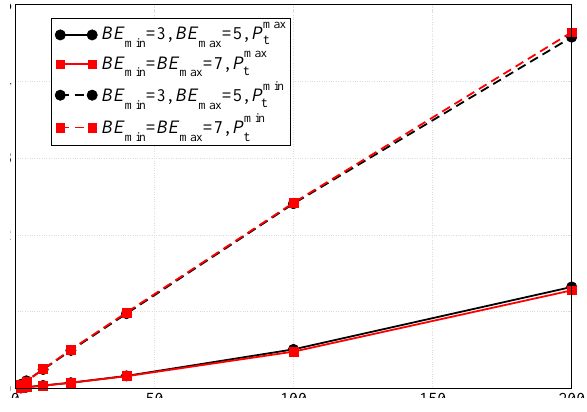
Figure 6. PER as a function of the total offered traffic load. The simulation results are obtained considering (i) default backoff exponent, i.e., BE modified backoff exponent, i.e., BE powers are considered. The allocated transmit power is the same at each node.